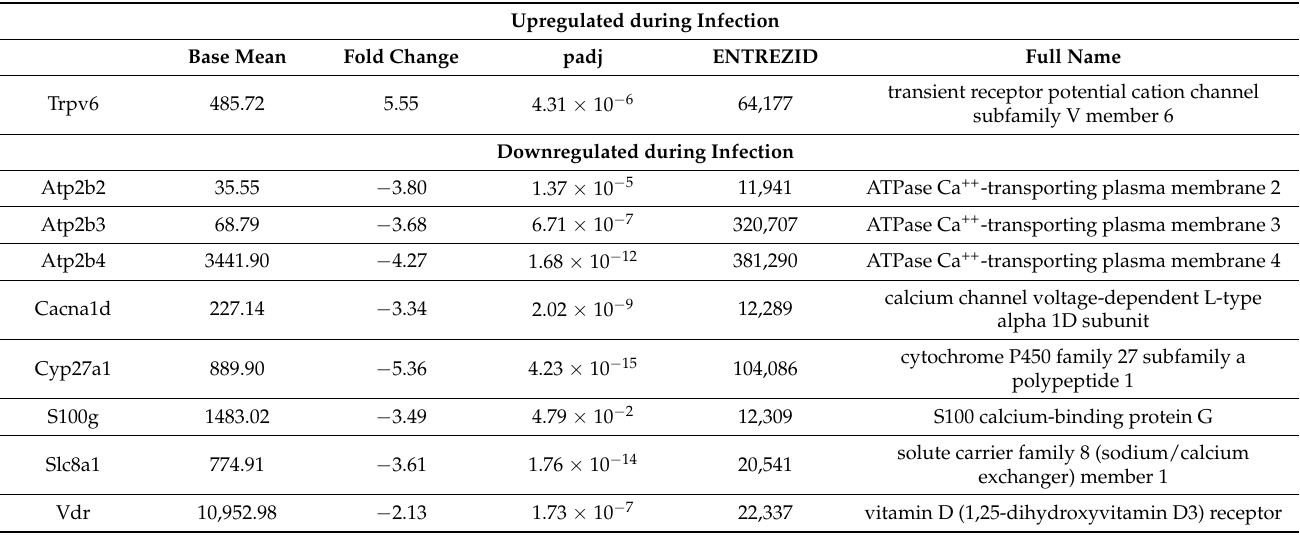
Table 3. VDR-related gene expression altered by the C. rodentium infection in the colon. Upregulated during Infection